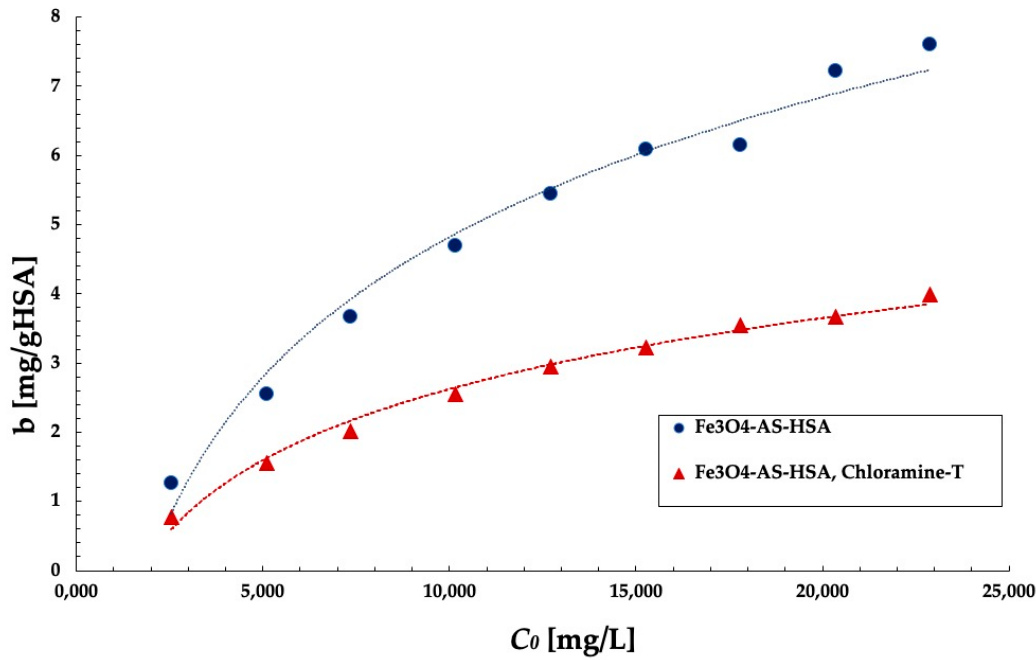
Figure 9. Binding isotherms of Fe 3 O 4 –AS–HSA before and after oxidative stress induced with chloramine-T. Error bars are smaller than the symbols. Table 6. Amount of bounded KP: (mg / gHSA and percent) for di ff erent initial KP concentration (mg /